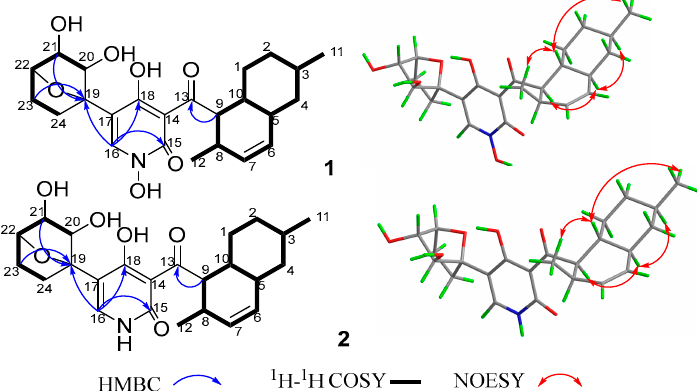
Figure 2. The key 2D NMR correlations of compounds 1 and 2 .